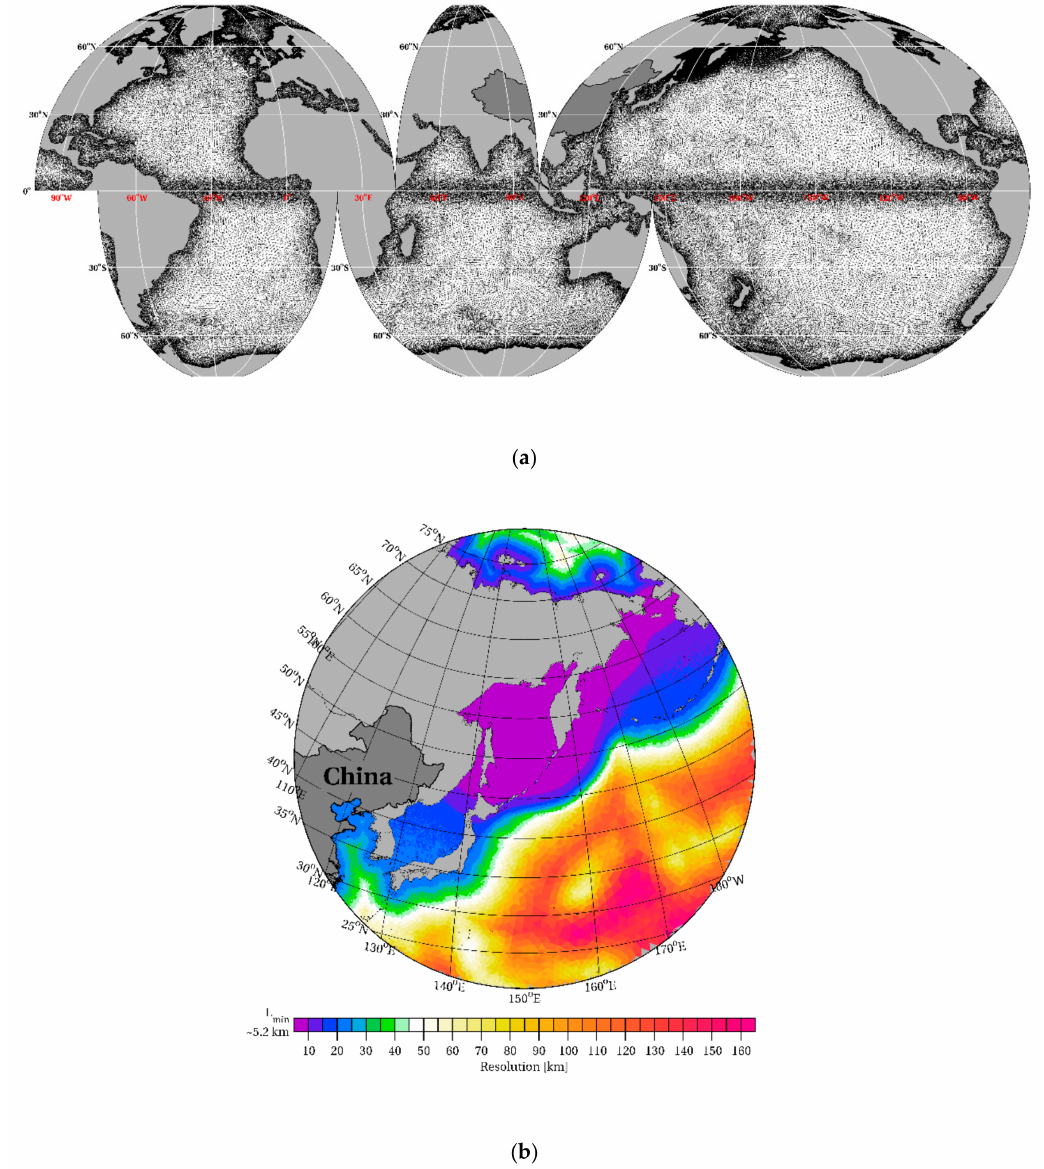
Figure 9. ( a ) Unstructured triangular Finite Element Sea Ice–Ocean Model (FESOM) surface mesh used in this project, with increased resolution along the bathymetric slope, as well as along the equator. ( b ) Zoom into the locally refined Sea of Okhotsk and Sea of Japan (up to 7 km resolution). For details of the model, we refer to Scholz et al.